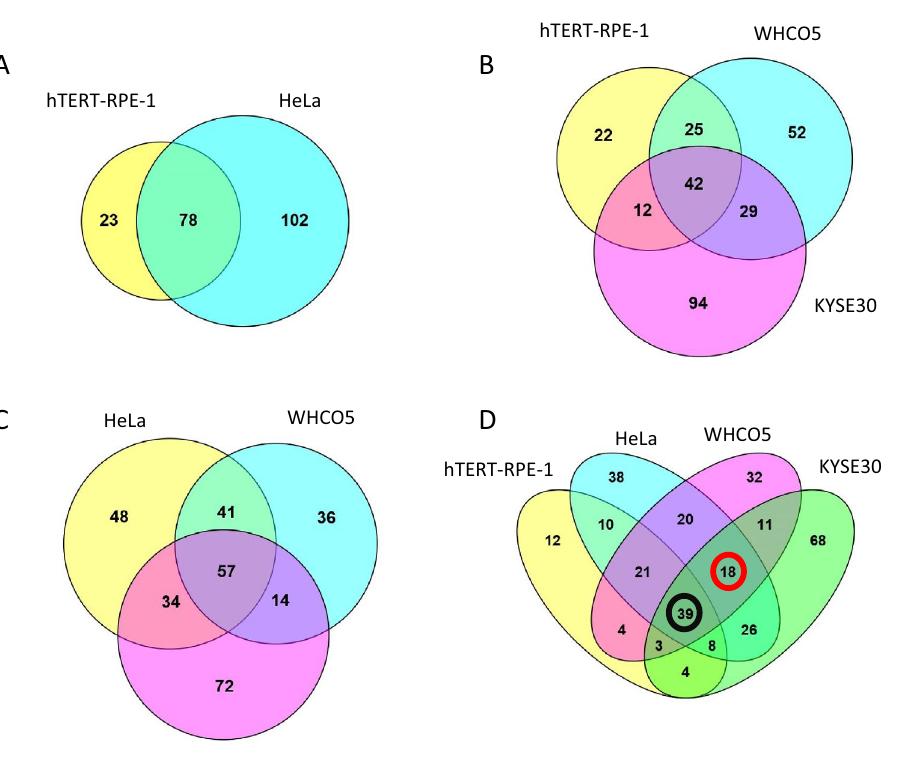
Figure 2. Venn diagrams of binding partners of Kpnβ1 identified using IP-MS. Venn diagrams were drawn representing overlaps in binding partners of Kpnβ1 in all replicates of ( A ) hTERT-RPE1 and HeLa cell lines, ( B ) hTERT-RPE1, WHCO5 and KYSE30 cell lines, ( C ) HeLa, WHCO5 and KYSE30 cell lines and ( D ) hTERT-RPE1, HeLa, WHCO5 and KYSE30 cell lines. The number of Kpnβ1 binding partners that are common to the normal and cancer cell lines is encircled in a black ring and the number of Kpnβ1 binding partners which are unique to the cancer cell lines is encircled in a red